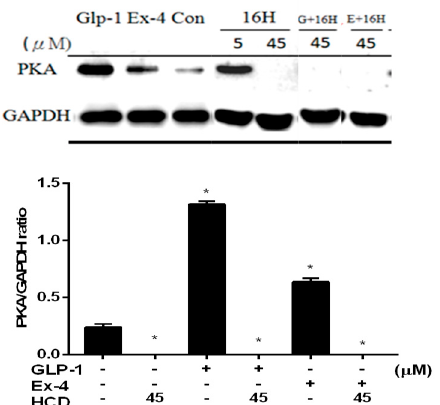
Figure 4. PKA level change after selected natural compounds’ treatment . Pancreatic cells were treated with and 16-hydroxycleroda-3,13-dien-15,16-olide (HCD & 16H) with/without GLP-1 (natural incretin) with and 16-hydroxycleroda-3,13-dien-15,16-olide ( HCD & 16H ) with / without GLP - 1 ( natural and exendin-4 (Ex-4, GLP-1 analogue) and PKA levels analyzed. PKA level was normalized with incretin ) and exendin - 4 ( Ex - 4, GLP - 1 analogue ) and PKA levels analyzed . PKA level was normalized GAPDH and mean ± SD shown from three independent experiments. * p < 0.05 was marked in the with GAPDH and mean ± SD shown from three independent experiments . * p < 0.05 was marked in column significantly different to the untreated control. the column significantly different to the untreated control .